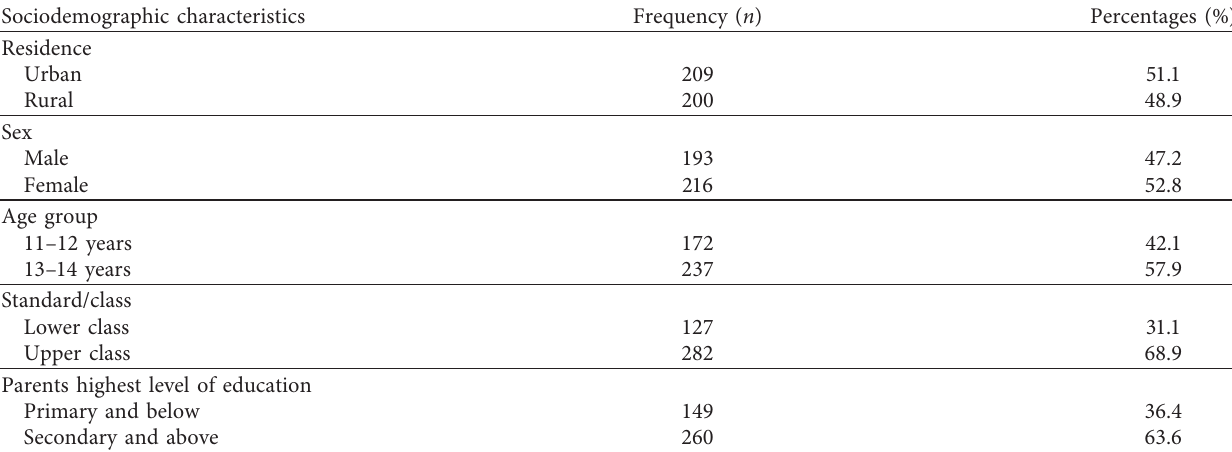
Table 1: Distribution of study participants by sociodemographic characteristics.